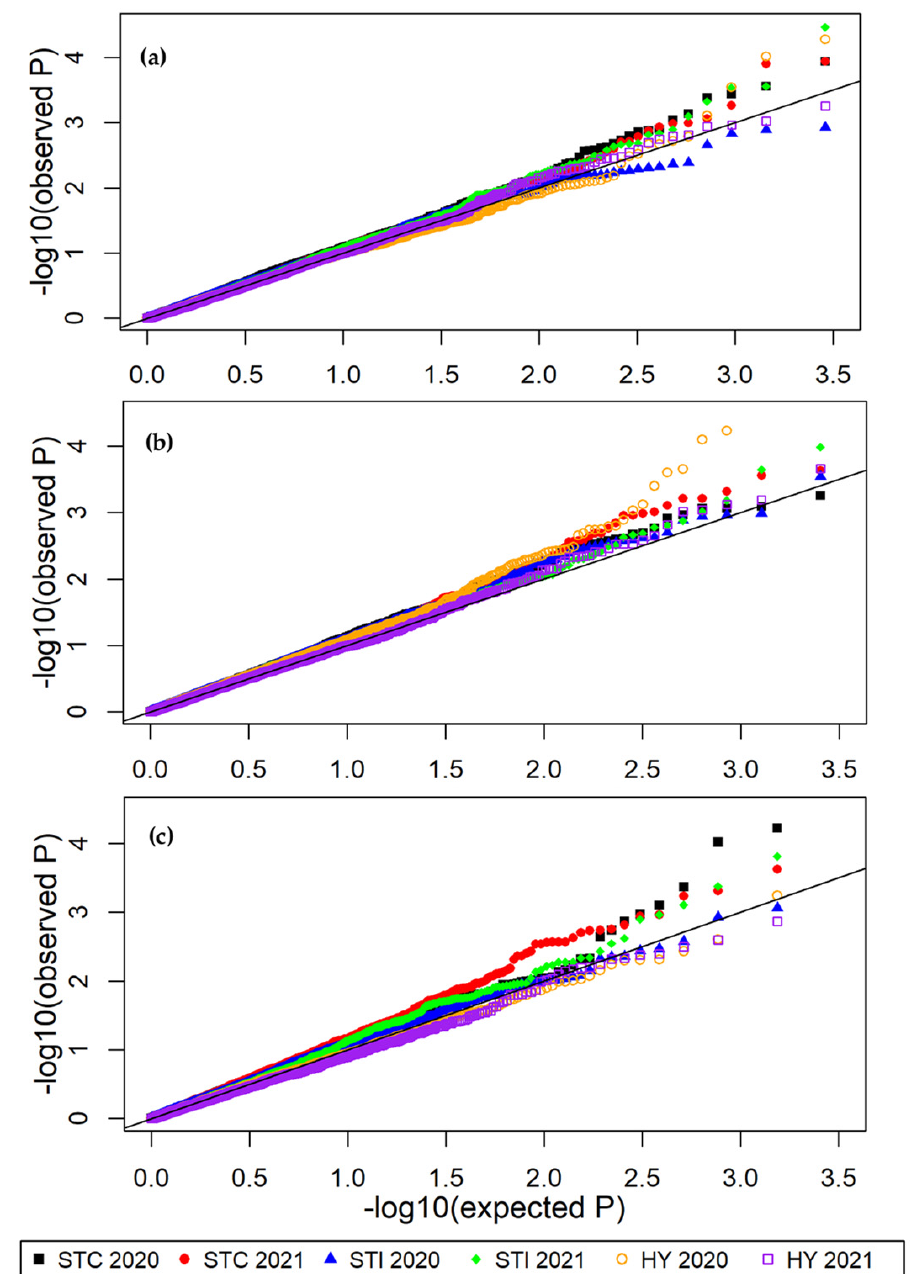
Figure 1. Quantile–quantile plots showing expected vs. observed log 10 (p) values for three macadamia traits in 2020 and 2021, for three panels: ( a ) M. integrifolia , M. tetraphylla , M. integrifolia × M. tetraphylla , ( b ) M. integrifolia , ( c ) M. tetraphylla . Trait × year combinations are represented by different symbols and colours. STC = log e (count of stick-tights), HY = harvestable yield; log e (count of nuts), STI = logit(stick-tight incidence (STC/(STC + HY)).